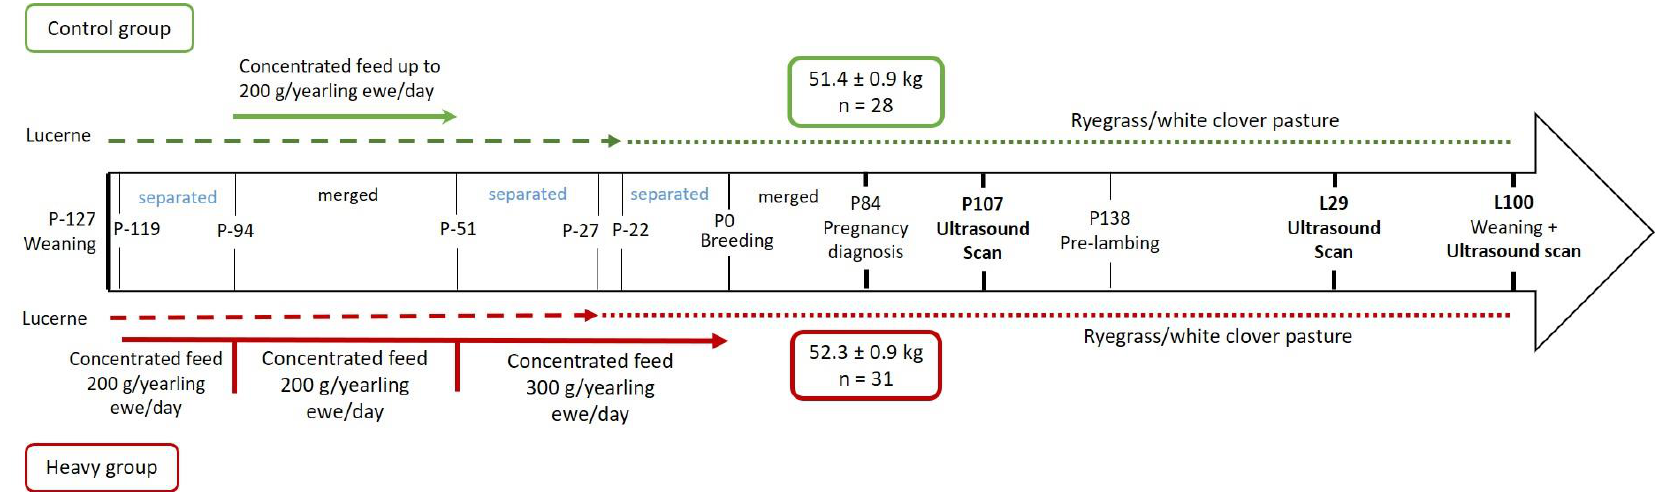
Figure 1. Experimental design from weaning of the yearling ewes (P-127) to weaning of their progeny (L100) (extended of [20] ). P: days of pregnancy, L: days of lactation. The lactation period was deemed to have begun after the first lamb of all yearling ewes was born (L1). The green colour (top) corresponds to the control group and the red colour (bottom) corresponds to the heavy group.